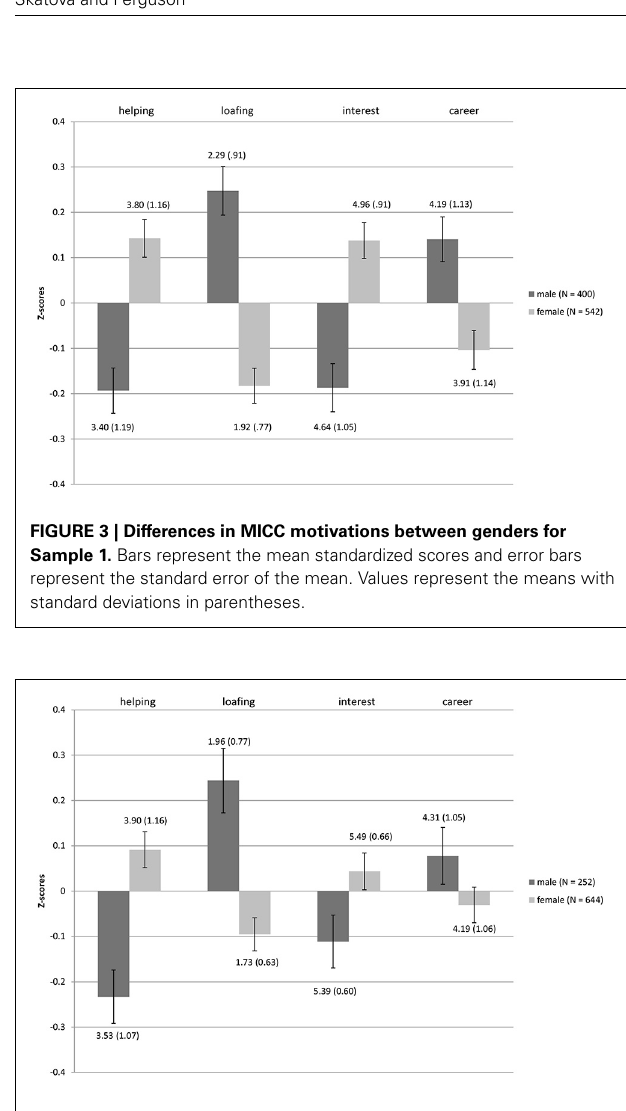
FIGURE 4 | Differences in MICC motivations between genders for Sample 2. Bars represent the mean standardized scores and error bars represent the standard error of the mean. Values represent the means with standard deviations in